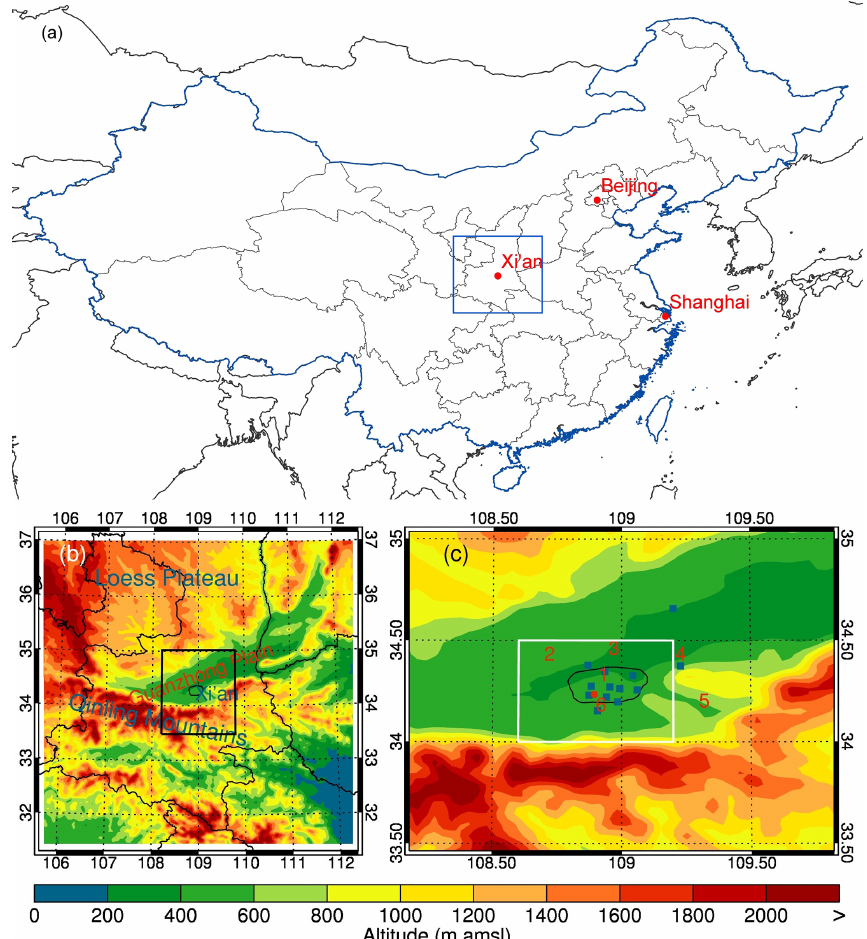
Figure 1. Map showing (a) the location of Xi’an in China, (b) WRF-Chem model simulation domain with topography, and (c) geographic distributions of surface monitoring stations. In (c) , the blue squares represent the chemical species monitoring stations and the red circle is the IEECAS site. The red numbers denote meteorological observation sites. 1: Xi’an; 2: Xianyang; 3: Jinghe; 4: Lintong; 5: Chang’an; 6: Lantian. In addition, the area surrounded by the white rectangle in (c) is defined as Xi’an and surrounding areas according to the plume movement, and the area surrounded by the black line is the urban region of